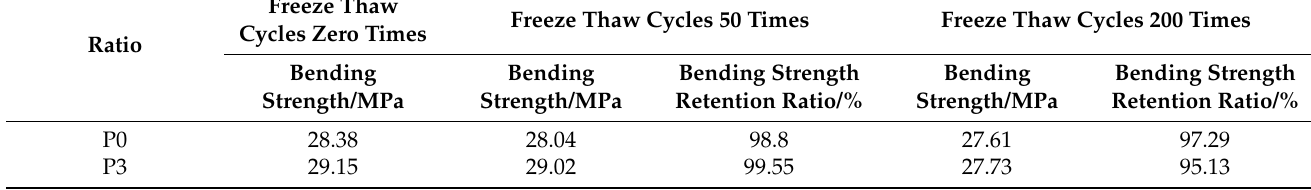
Table 7. The freeze–thaw cycle resistance of the repair